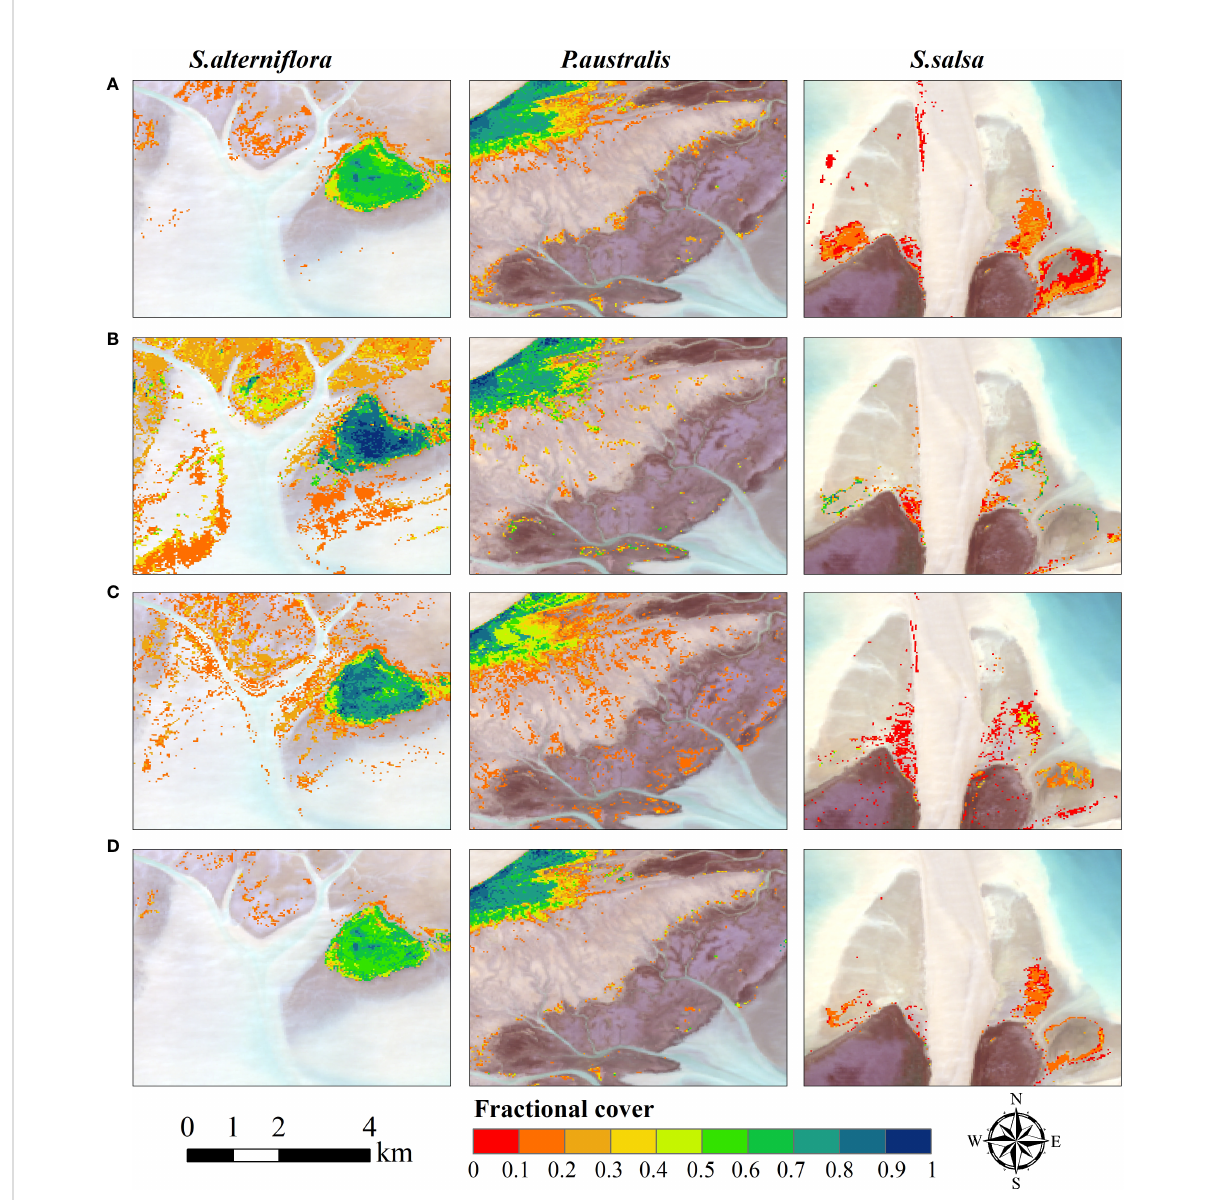
FIGURE 10 Fractional cover of S. alterni fl ora (left column), P.australis (middle column), and S.salsa (right column) from (A) RFR; (B) KNNR; (C) GBRT and (D) ELM in the three sub-areas shown in Figure 8D (black